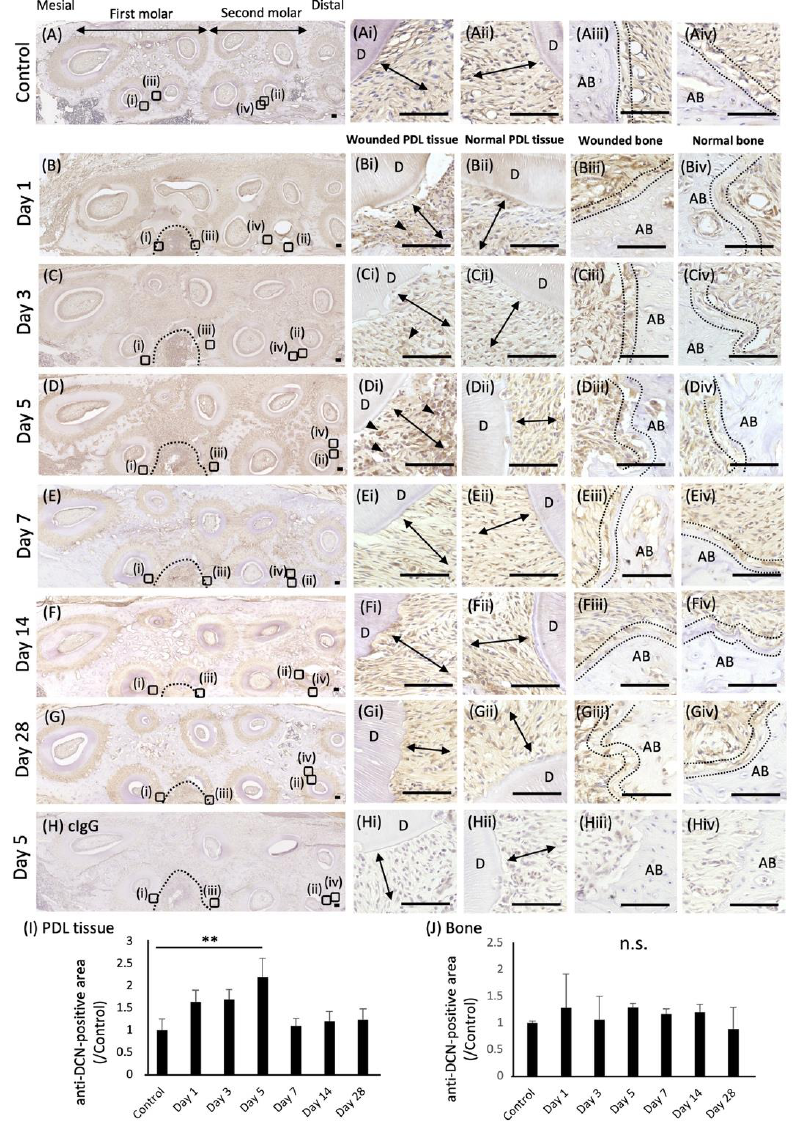
Figure 1. Expression of DCN in wounded rat periodontal tissue. Immunochemical analysis of DCN expression was performed in wounded rat periodontal tissue, including PDL tissue and the alveolar bone. Horizontal sections of rat maxilla were prepared, and preoperative sections were used as a control ( A ). Localization of anti-DCN antibody-positive areas in the wound site was examined on days 1 ( B ), 3 ( C ), 5 ( D ), 7 ( E ), 14 ( F ), and 28 ( G ). Magnified images of wounded PDL tissue (i), normal PDL tissue (ii), wounded alveolar bone (iii), and normal alveolar bone (iv) in each section are shown. Control IgG was used for the negative control ( H ). Nuclei were counterstained with hematoxylin. Arrowheads indicate anti-DCN antibody-positive areas. Double arrows indicate PDL tissue. The inside of the two dotted lines exhibits osteoblastic layers. D, dentin; AB, alveolar bone. Bars = 100 µm. ( I , J ) Graphs show the quantification of anti-DCN antibody-positive areas in the PDL tissue ( I ) or the osteoblastic layer around the alveolar bone ( J ). Anti-DCN antibody-positive areas in preoperative periodontal tissue were used as the control. Values are shown as the fold increase relative to the control. ** p < 0.01, n.s. = no significance, n =